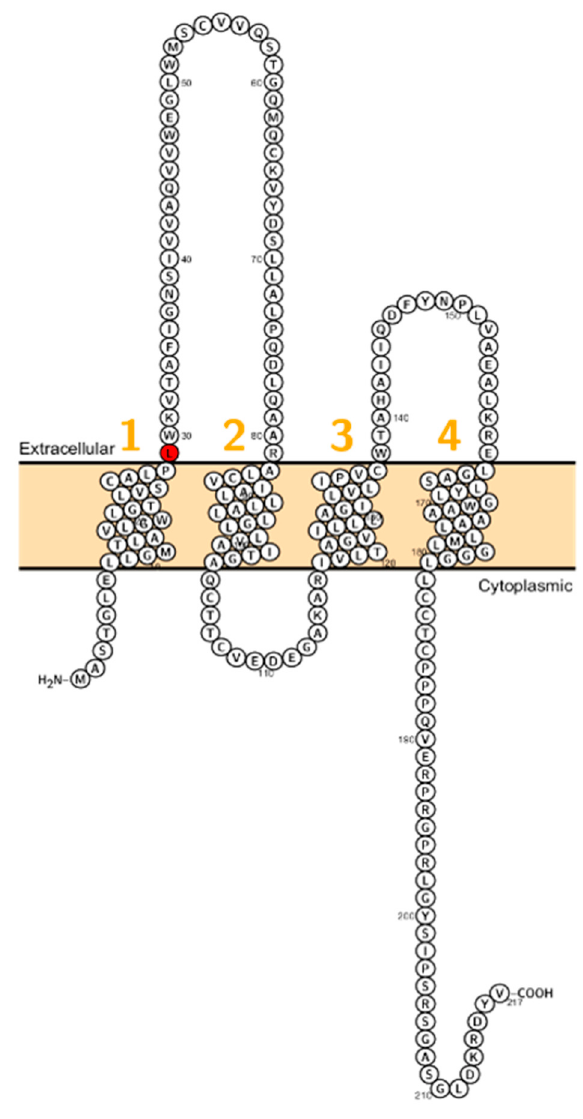
Figure 3. Topology of CLDN9 . FASTA sequence of CLDN9 (Uniprot accession no: O95484). Each amino acid is shown as a single letter code and numbers (orange) indicate transmembrane domains. Mutations shown to be involved in human diseases are shown in red.